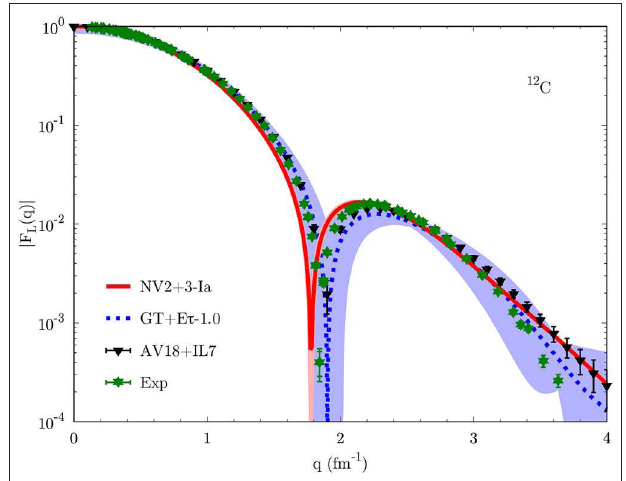
FIGURE 8 | Same as Figure 7 but for 12 C. Experimental data are taken from reference [132]. Adapted from reference [89].